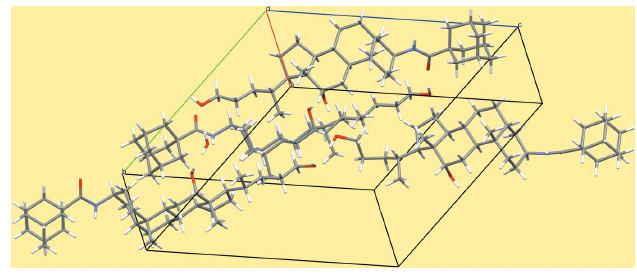
Figure 2 Packing diagram for the title compound.